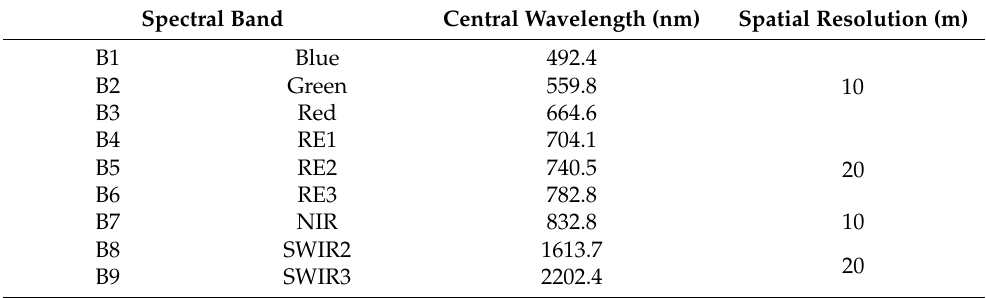
Table 1. Specification of Sentinel-2 multi-spectral bands (RE: red-edge; NIR: near-infrared; SWIR: shortwave infrared).